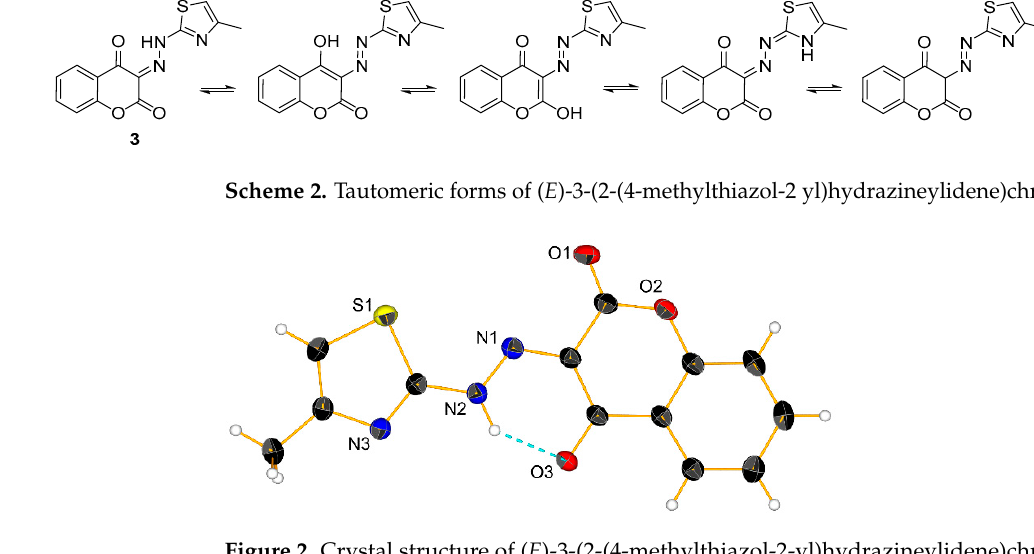
Figure 2. Crystal structure of ( E )-3-(2-(4-methylthiazol-2-yl)hydrazineylidene)chromane-2,4-dione ( 3 ). Thermal ellipsoids are at 30% probability.